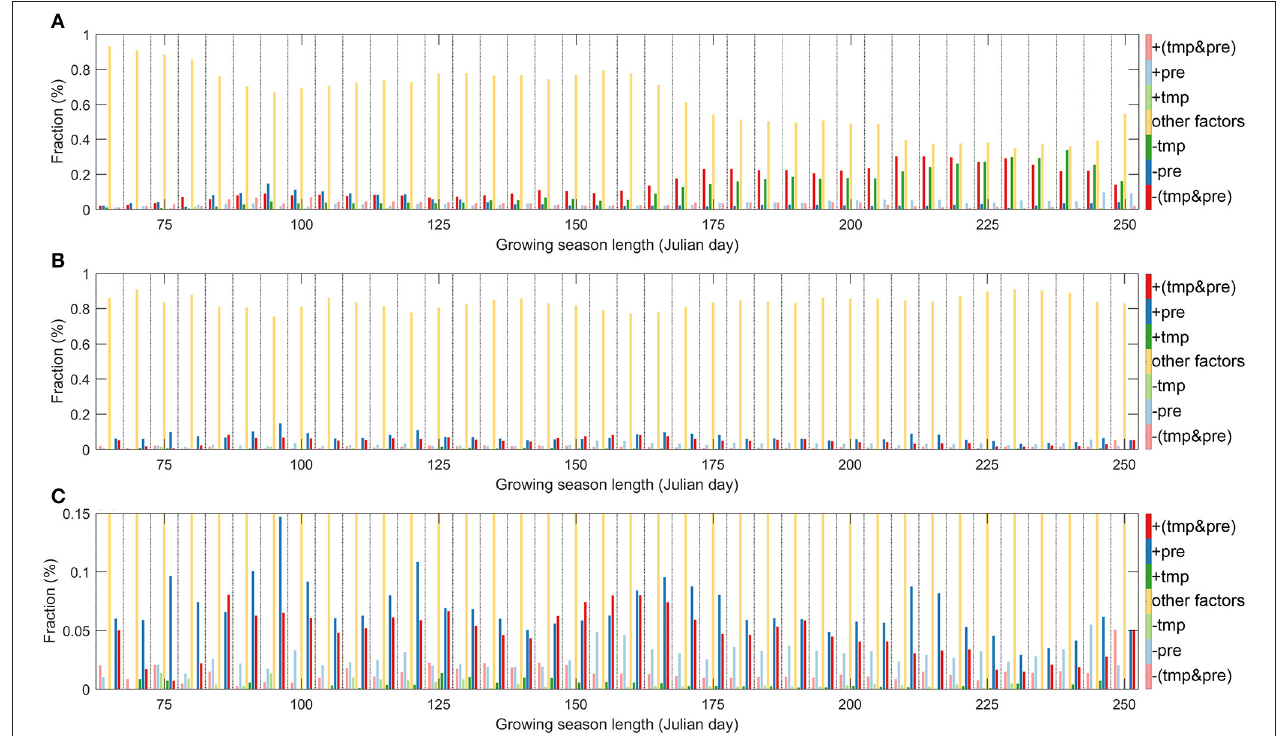
FIGURE 4 | The effect factors of SOS (A) and EOS (B) on growing season length, and the magnified climatic effects in EOS (C)